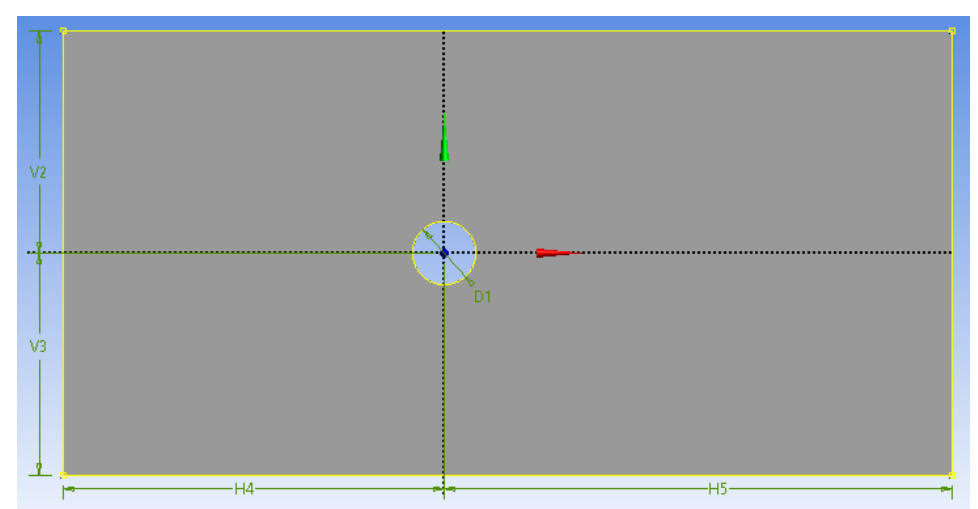
Figure 9. The parameters of the 2D CALM buoy model setup in ANSYS Fluent.